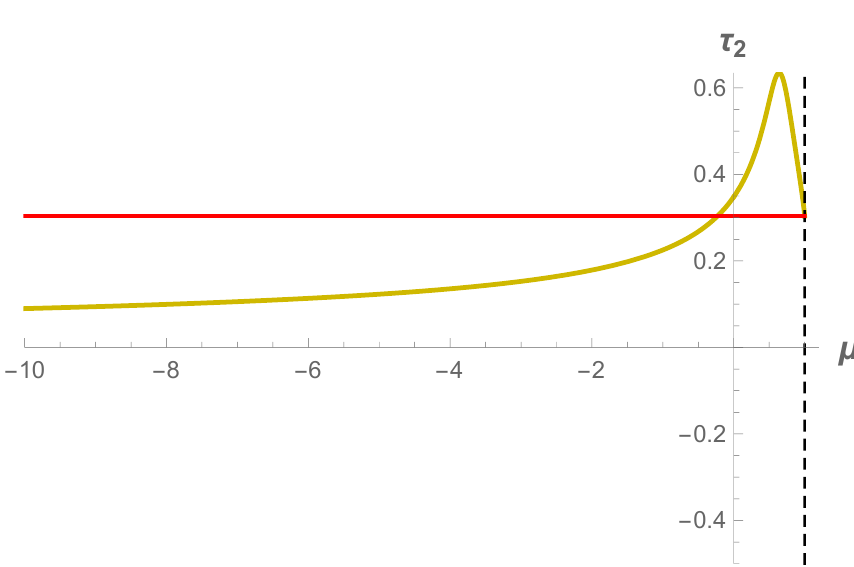
Figure 8 . The function τ 2 ( µ ) in the [H1,E2] and [H1,E2 0 ] branches of solutions, for 2 ‘ 2 = 3 ‘ 1 and √ 5 / 2 ‘ . The red line indicates the bound τ ∗ λ = 3 / 5 ‘ 2 < λ 0 = 2 to